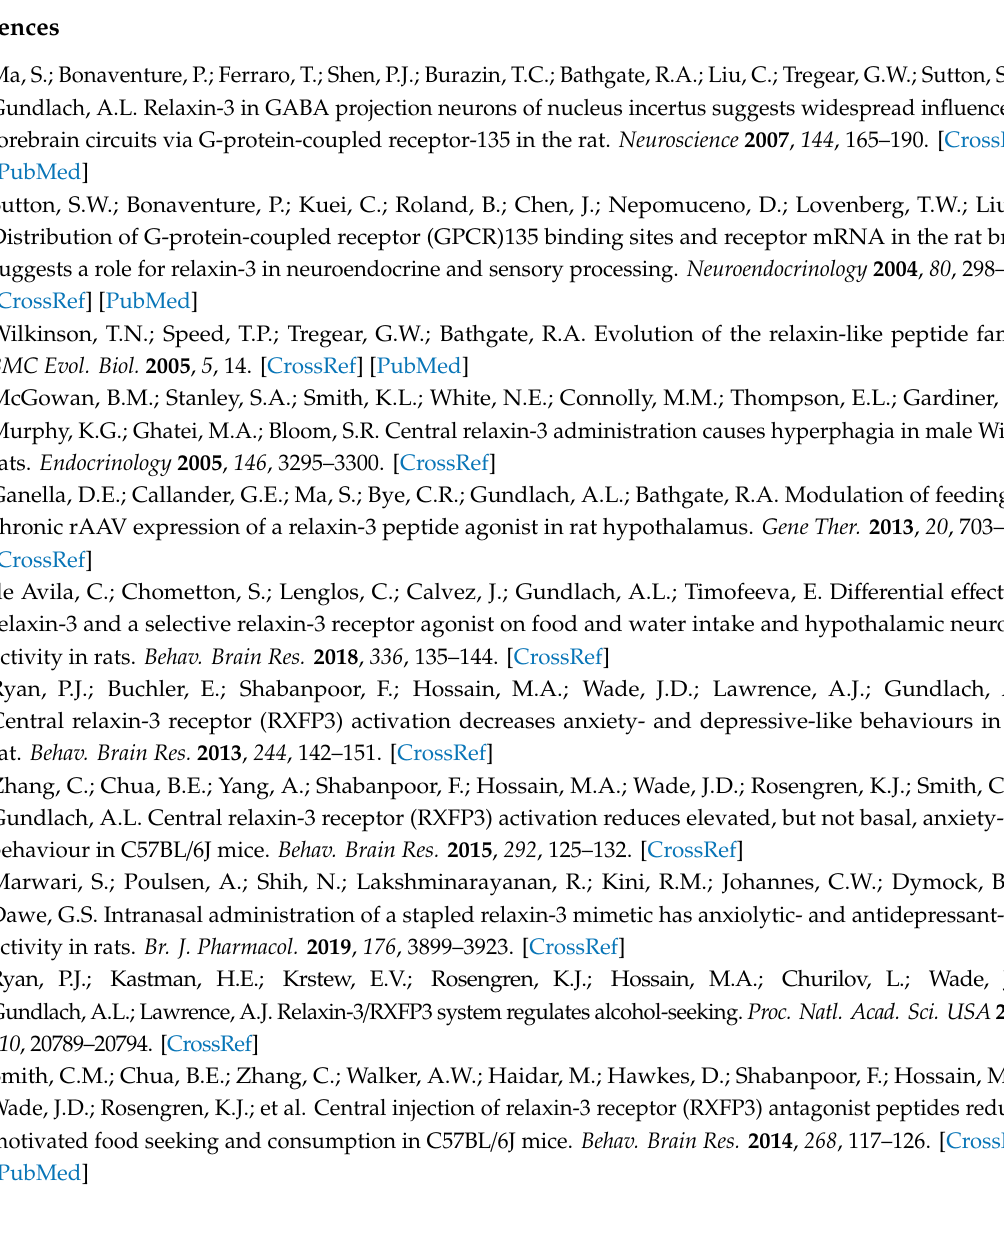
Figure S1: Mass spectra of analogues 1 – 6 and their corresponding analytical HPLC traces, Figure S2: Mass spectra of analogues 7 – 12 and their corresponding analytical HPLC traces, Figure S3: Mass spectra of analogues 13 – 17 and their corresponding analytical HPLC